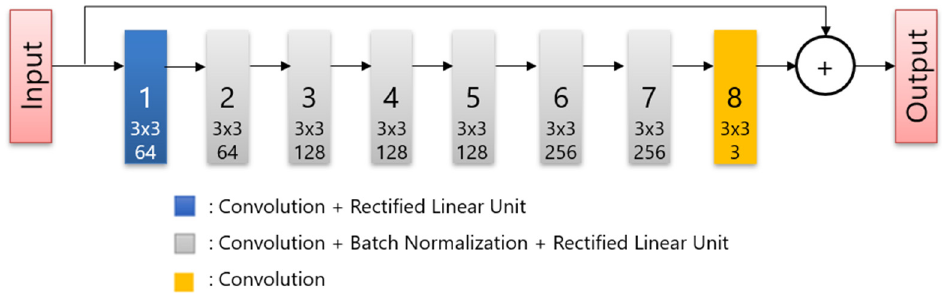
Figure 1. The structure of the deep convolutional network.